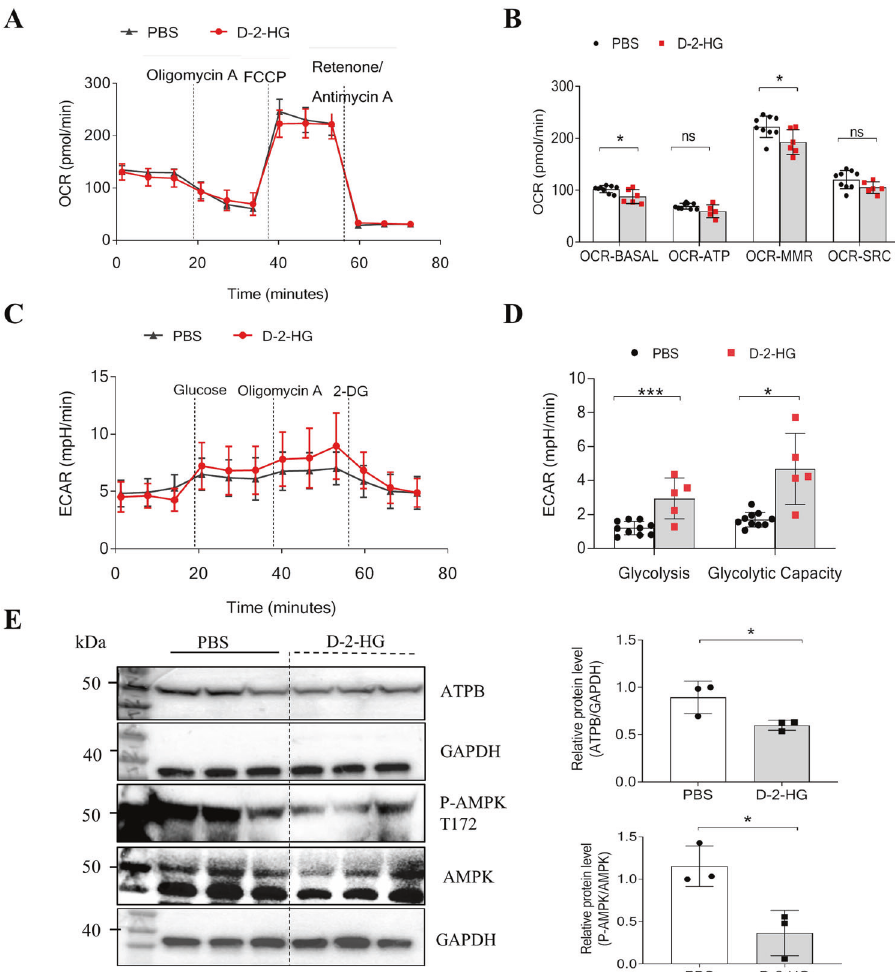
respiratory function: basal respiration (OCR-BASAL), ATP production (OCR-ATP), maximal respiration (OCR-MMR), and spare respiratory capacity (OCR-SRC) in liver organoids. C Representative ECAR experiments performed on liver organoids treated with PBS or 5 mM D-2-HG. D Levels of glycolysis and maximal glycolytic capacity in liver organoids. E At 4 h after PBS or 5 mM D-2-HG exposure, the proteins of the EpCAM + cells were extracted for western blotting (WB). The WB was used to determine the amounts of P-AMPK, AMPK, and ATPB ( n = 3). ns, not signi fi cant, * P < 0.05, *** P <